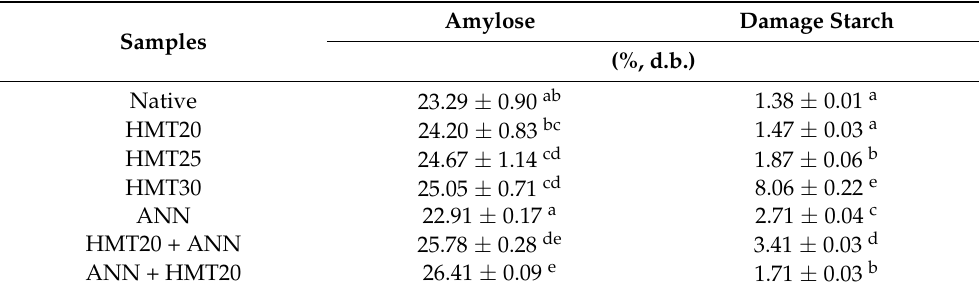
Table 3. Effect of various hydrothermal treatments on the amylose and damaged starch content of water caltrop starch 1,2